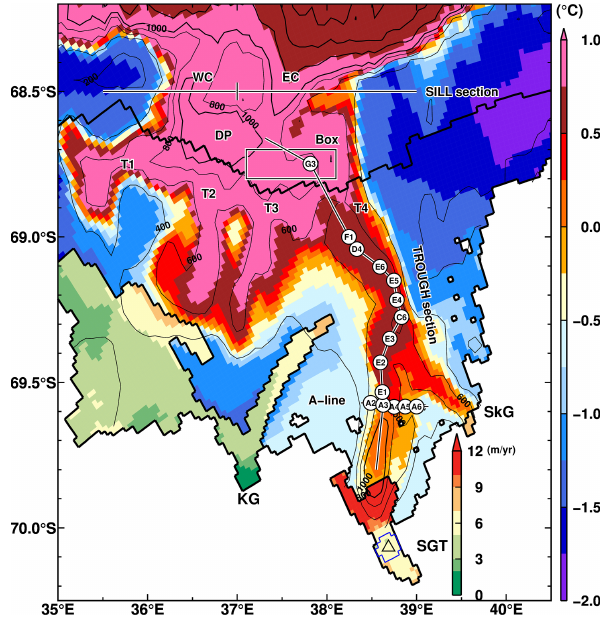
Figure 8. Key sections and observational stations used in this study. Colors represent the modeled ocean bottom temperature in January and the annual mean basal melt rate in the NOFI case. The variables were averaged over the period 2008–2018. White circles with sta- tion names show positions of the in situ oceanographic observations for the comparisons in Figs. 9 and 11. Black lines connecting the ob- servational stations are defined as the TROUGH section and A line. The thick zigzag black lines are the grounding line, the ice-front line, and the fast-ice edge in the FI case. The area enclosed with the blue line on the SGT is the averaging area for calculating the regional basal melt rate around the location of ApRES (triangle). SGT indicates the Shirase Glacier tongue; SkG indicates Skallen Glacier; KG indicates Kaya Glacier. WC and EC refer to the west- ern and eastern submarine canyons, respectively. T1, T2, T3, and T4 refer to the troughs in the LHB. Sill sections near the shelf break are used to show vertical profiles in Fig. 9. A box is used for averaging ocean properties in Figs. 12 and 20.